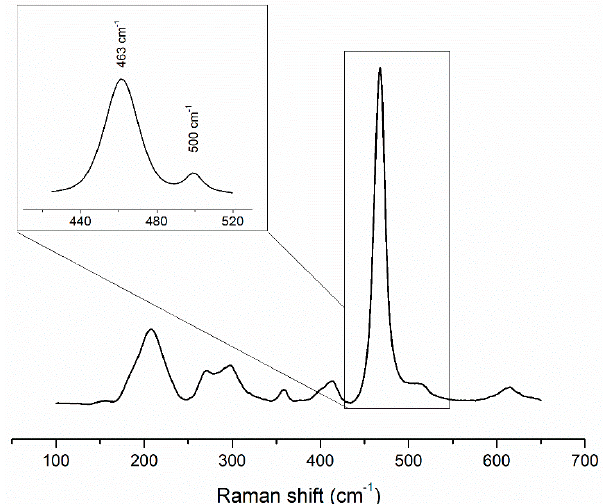
Figure 9. Raman spectrum of S2 sample. In the inset, the spectrum between 420 and 520 cm − 1 showing the band corresponding to moganite (500 cm − 1 ) and quartz (463 cm − 1 ). In SAED micrographs of S2 sample particles (Figure 10) interplanar distances of 1.28, 1.45, 1.79, 2.44, 3.37 and 4.30 Å can be attributed to moganite [29], since they coincide with the d hkl (604), (600), (006), (020), (202) and (200), respectively.